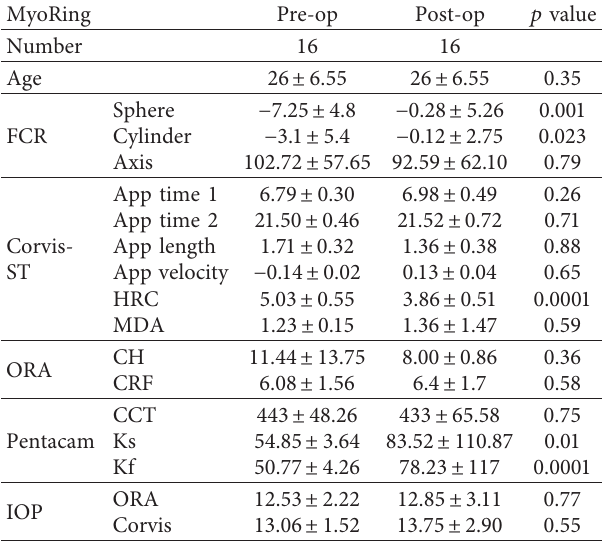
Table 2: The results of parameters of the group 1 (MyoRing) before and after the ICRS implantation.